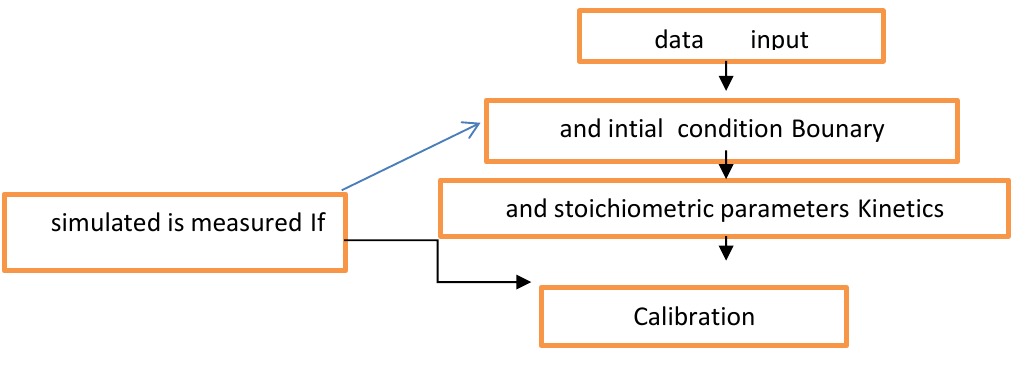
Fig. 2. Different stages in calibrating CWM1.